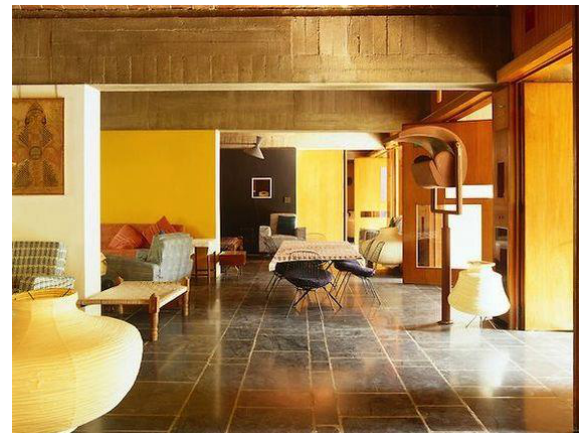
Figure 13. Villa Sarabhai, Ahmedabad